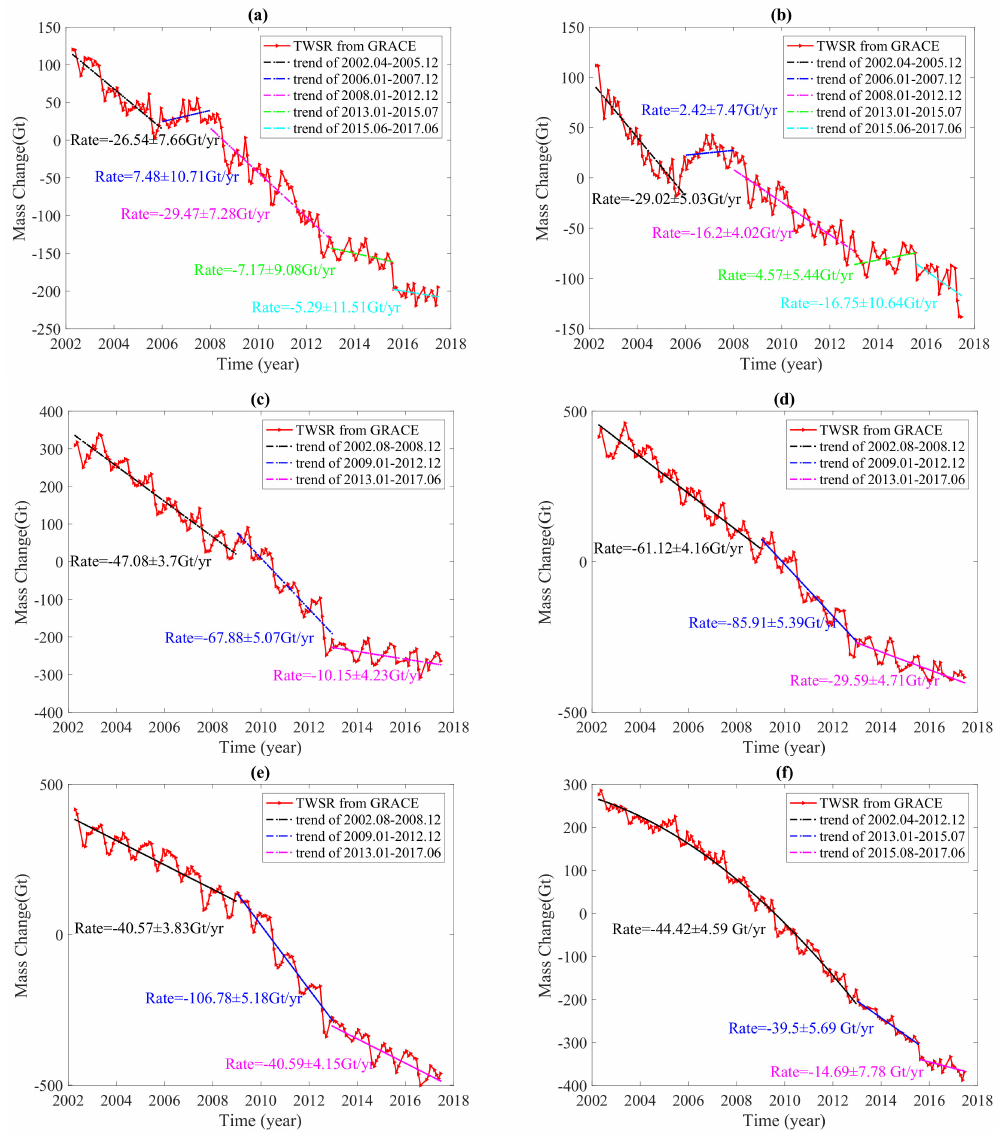
Figure 4. Mass changes in the drainage basins (see Figure 1) ( a ) NO, (b) NE, ( c ) CE, ( d ) SE, ( e ) SW, and ( f ) NW estimated based on averaging the GRACE monthly solutions from four processing centers between April 2002 and June 2017 with a forward modeling technique applied to suppress the ocean–land leakage e ff